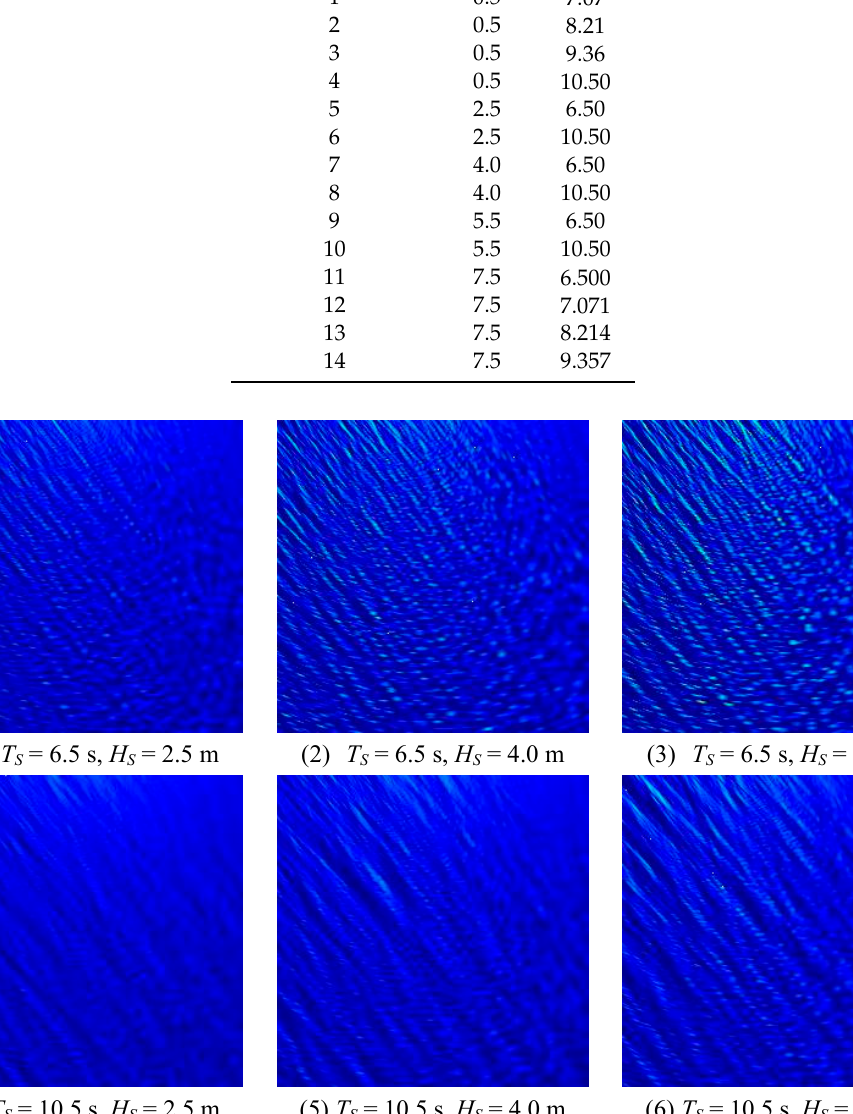
(b) Inversion results of H S Figure 8. Inversion results of the CNN-based models trained by the initial training data set. We can see that there were obvious errors because of the difference between the test samples and the training data. To address this problem, we expanded the training data set as shown in Figure 9; one radar image was generated every 0.008 s in T S at the same H S , and one radar image was generated every 0.014 m in H S at the same T S . We trained the CNN-based models with the expanded training data set. Afterward, the two models were used to inverse H S and T S of the 14 test samples. Results are shown in Figure 10.